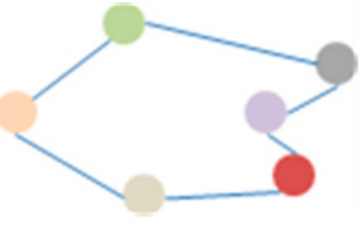
Figure 5. The COG of a Polygon.